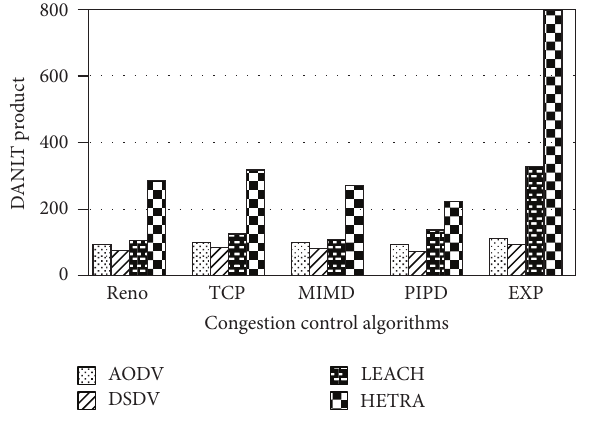
Figure 12: DANLT product for Pattern 5.